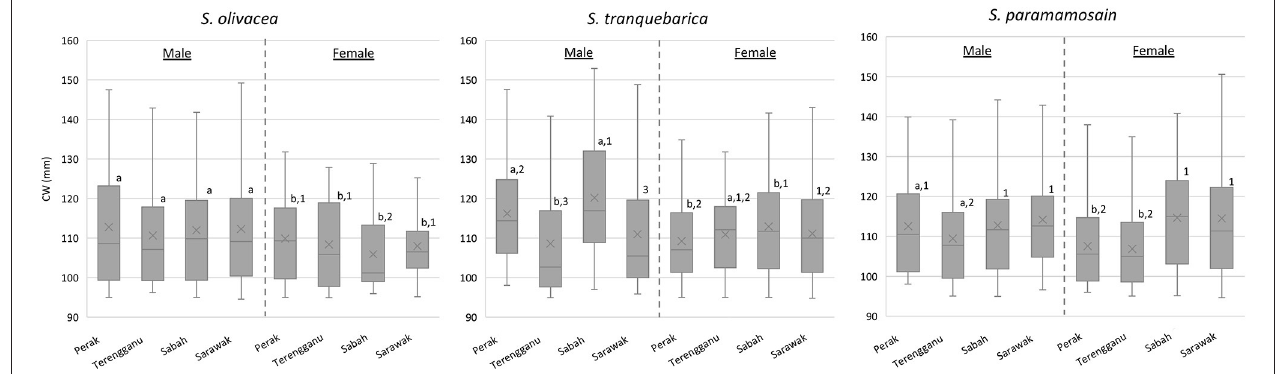
FIGURE 2 | The boxplots of carapace width (CW) of Scylla species are based on sex and location. Superscript alphabets represent significant differences among male-female comparison within the same species and location ( P < 0.05); Superscript Arabic numerals represent significant differences among locations within the same species and sex ( P < 0.05); No superscript alphabet/Arabic numeral was used for groups with no significant